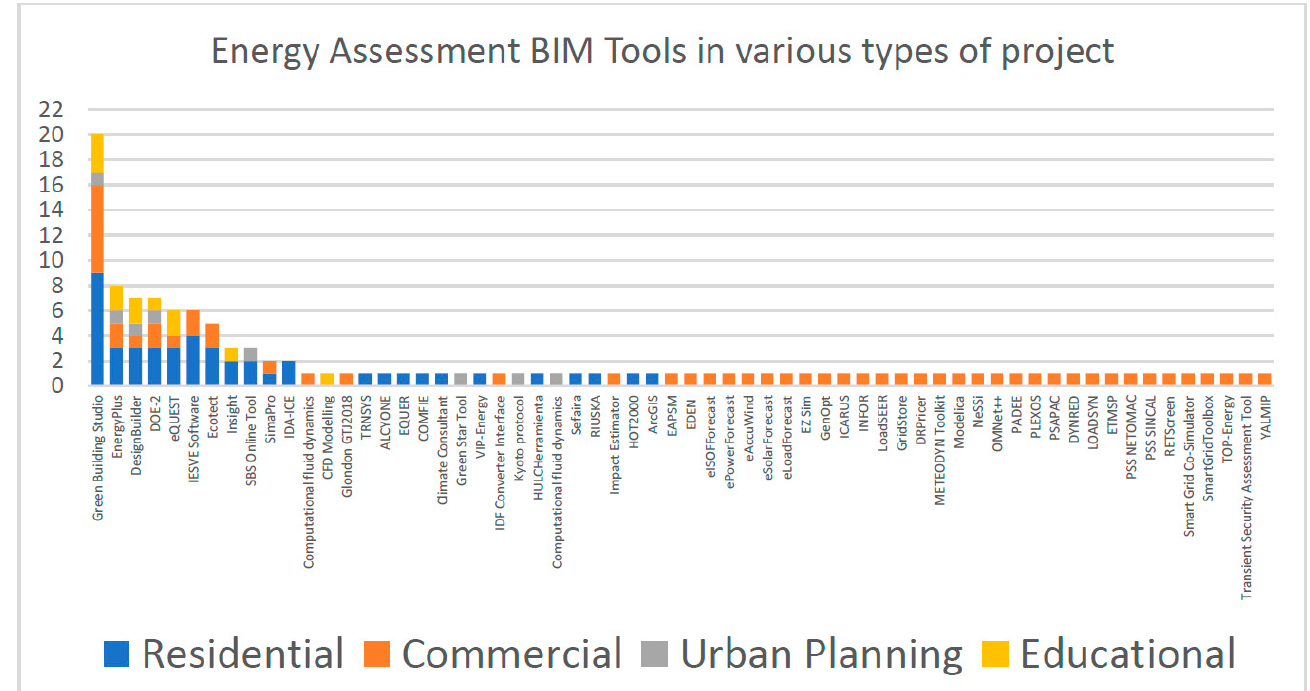
Figure 4. Energy Assessment BIM Tools in various types of projects.